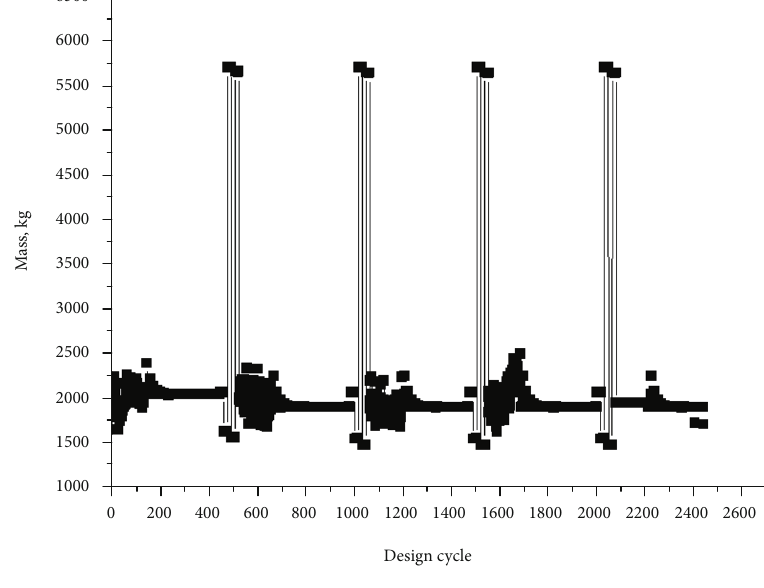
Figure 6: Optimization history. Table 2: Comparisons of preoptimization and postoptimization location distribution and